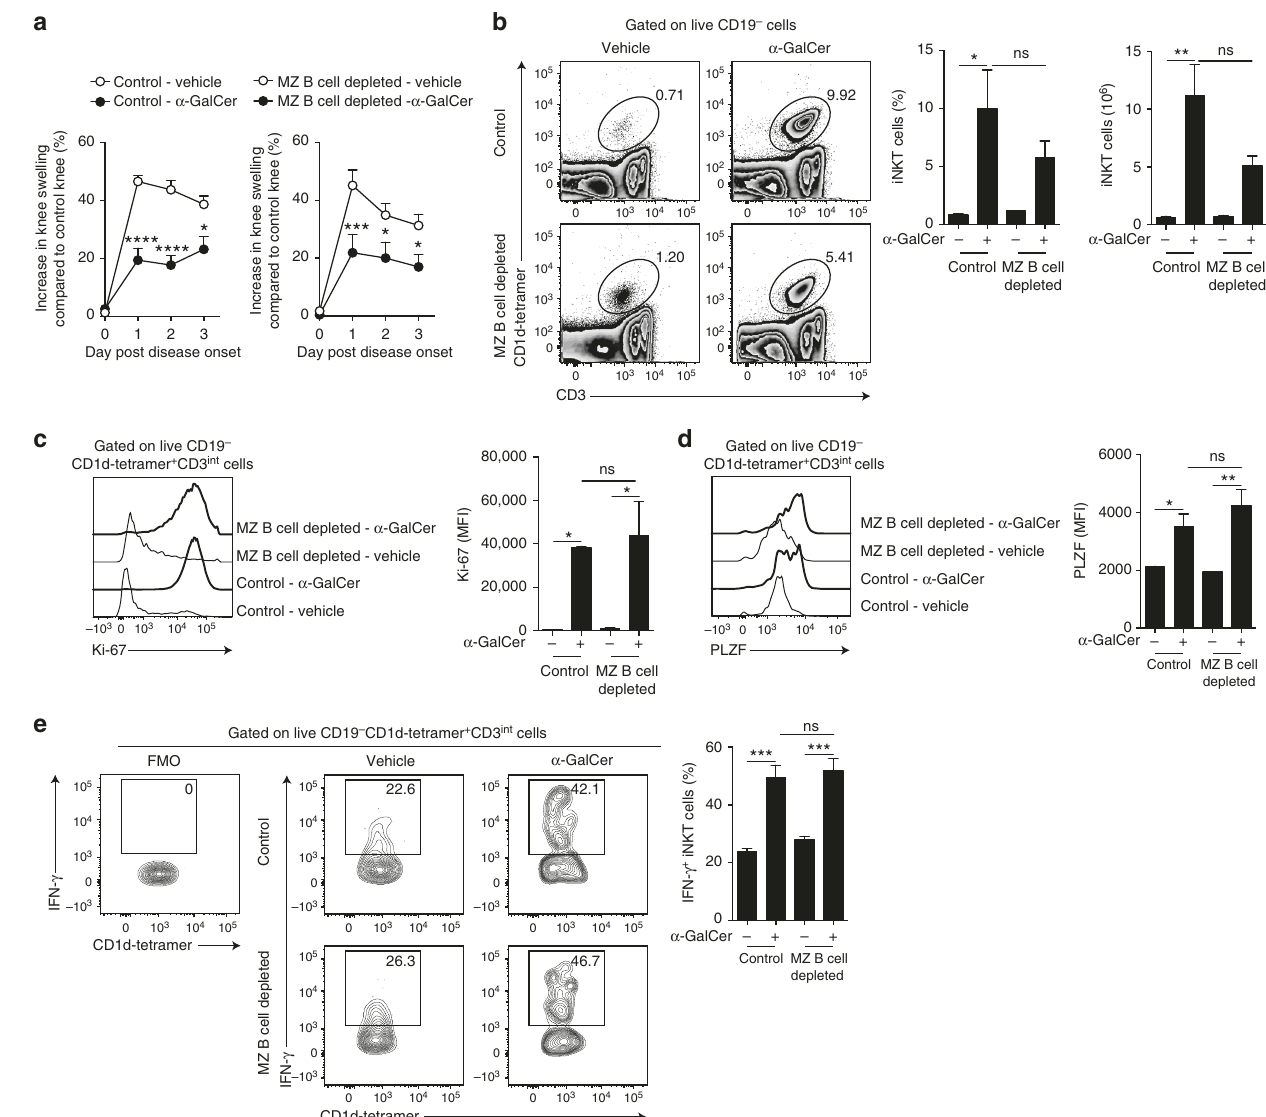
Fig. 7 MZ B cells are dispensable for α -GalCer-mediated amelioration of arthritis. a Mean clinical score of control mice (left) or MZ B cell-depleted mice (right) that received α -GalCer or vehicle alone following induction of arthritis. The Y axis shows the percentage of swelling in antigen-injected knee compared to control knee ( α -GalCer-treated n = 5 per group, vehicle-treated n = 6 per group, one of two experiments is shown). b Representative fl ow cytometry plots and bar charts showing the frequency and number of splenic iNKT cells in MZ B cell-depleted mice and control mice that received α - GalCer or vehicle alone ( n = 3 per group, one of two experiments is shown). c Representative histograms and bar chart showing MFI of Ki-67 in splenic iNKT cells from α -GalCer- or vehicle-treated MZ B cell-depleted mice and control mice ( n = 3 per group, one of two experiments is shown). d Representative histograms and bar chart showing MFI of PLZF in splenic iNKT cells from α -GalCer- or vehicle-treated MZ B cell-depleted mice and control mice ( n = 3 per group, one of two experiments is shown). e Representative fl ow cytometry plots and bar chart showing the frequency of IFN- γ + splenic iNKT cells from α -GalCer- or vehicle-treated MZ B cell-depleted mice and control mice ( n = 4 per group, one of two experiments is shown). b , c Analyzed on day 3 post disease onset; d , e analyzed at 16 h post disease onset. Data are mean ± s.e.m. ns not signi fi cant, * p < 0.05, ** p < 0.01, *** p < 0.001, and **** p < 0.0001 ( a two-way ANOVA; b – e one-way